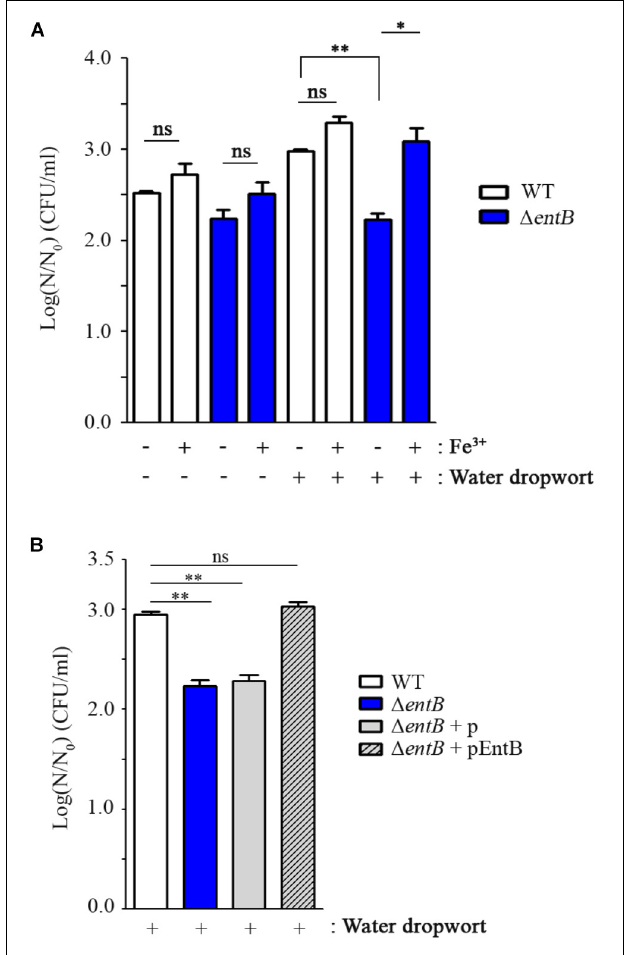
FIGURE 3 | Comparison of bacterial growth between FORC_035 wild-type (WT) and (cid:49) entB mutant strains. (A) Ferric sulfate (10 µ M) was added to M9 minimal media with or without water dropwort. (B) Four strains of WT, (cid:49) entB, and (cid:49) entB with either empty plasmid or pEntB were cultivated in the presence of water dropwort. pUHE21-2 lacI q plasmid was used and 50 µ M of IPTG was used for induction. In both graphs, live bacterial numbers were measured in M9 minimal medium broth supplemented with water dropwort after a 5-h incubation. Viability of bacterial cells was measured by comparing log( N / N 0 ) values, where N 0 is the initial number of cells at 0 h and N is the number of cells after a 5-h incubation. The t -test was used to evaluate the significance of differences in viability, and significance is indicated as follows: ∗ P < 0.05; ∗∗ P < 0.01; ns, not significant.